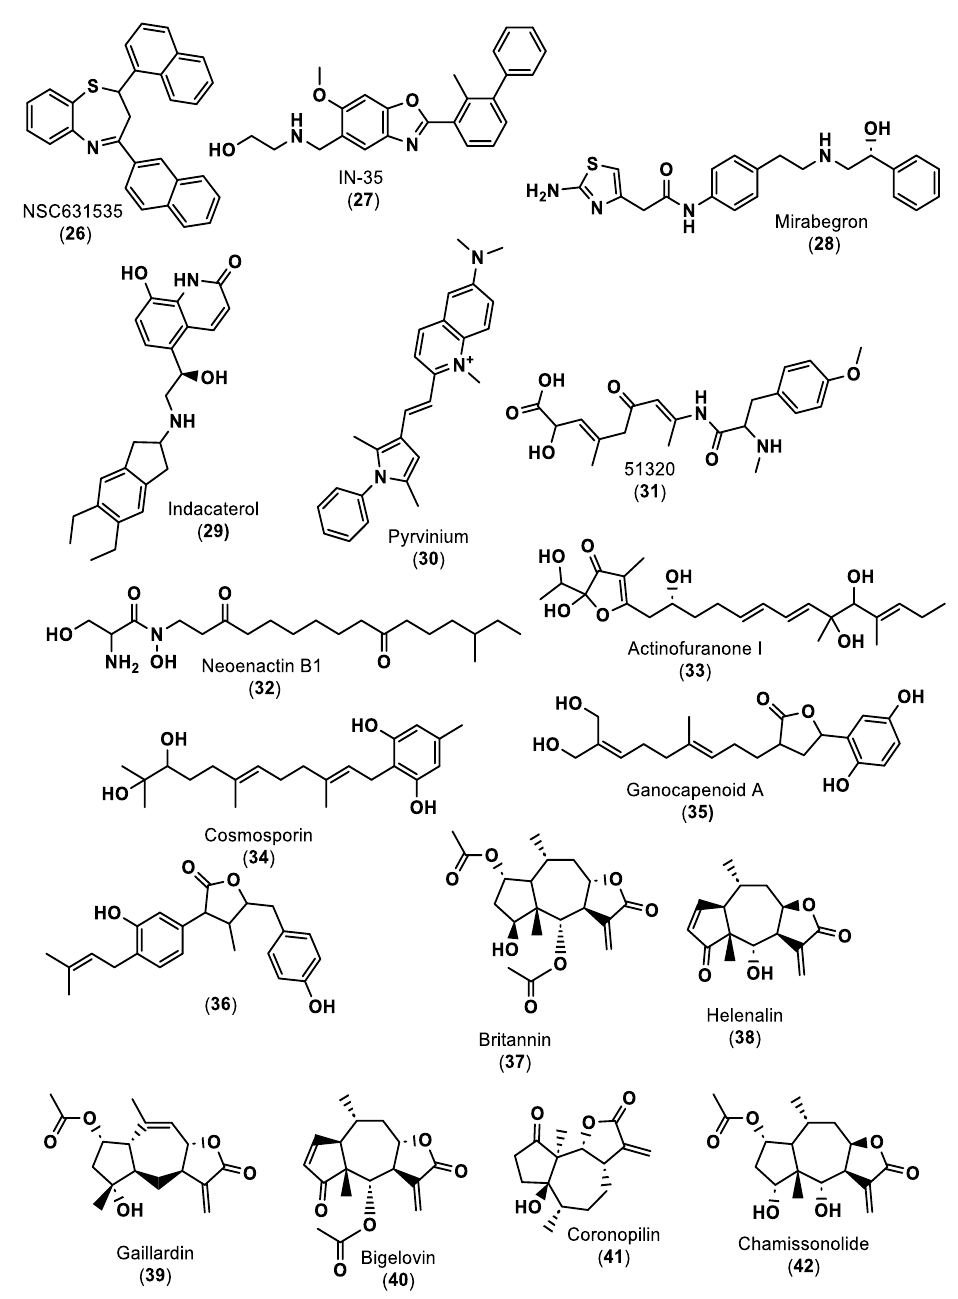
Figure 6. Small molecule inhibitors of PD-1/PD-L1 immune checkpoint [51,65,77,78,80–82]. Luo and co-workers [80] also used a structure-based PBVS approach, applying Dis- covery Studio 4.5 to establish a pharmacophore model using PD-L1/small molecule in- hibitors downloaded from PDB after screening marine small molecule databases such as the Comprehensive Marine Natural Products Database (CMNPD, https://www.cmnpd.org/ (accessed on 28 February 2023)) and the Seaweed Metabolite Database (SWMD, http: //www.swmd.co.in/ (accessed on 28 February 2023)) according to the properties of the pharmacophore. The compounds matched from the different databases were transferred to a list for another virtual screening based on pharmacophore characteristics, yielding a total of 12 hits. Then, two compounds were selected for further evaluation based on their molecular docking scores. Afterward, ADME (absorption, distribution, metabolism and excretion), toxicity and docking studies were performed using the SwissADME,